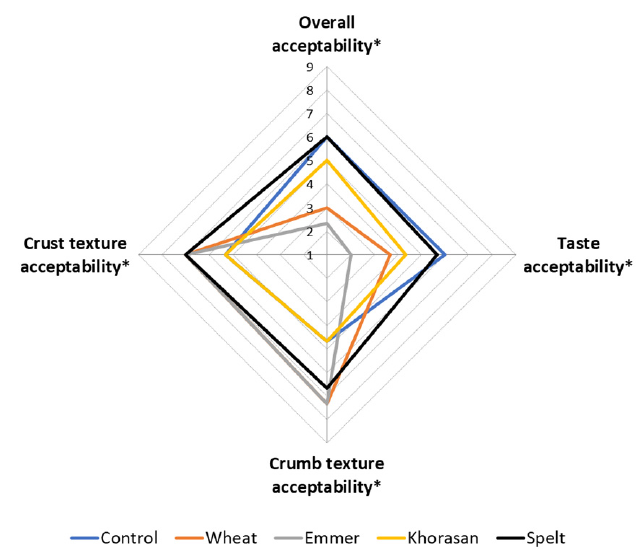
Figure 5. Spider plot of the sensory acceptance (overall, taste, crumb and crust texture) given by the consumers for the bread samples (* indicate significant ( p < 0.05) difference in acceptability between the bread samples according to the Tukey’s minimum square difference test).